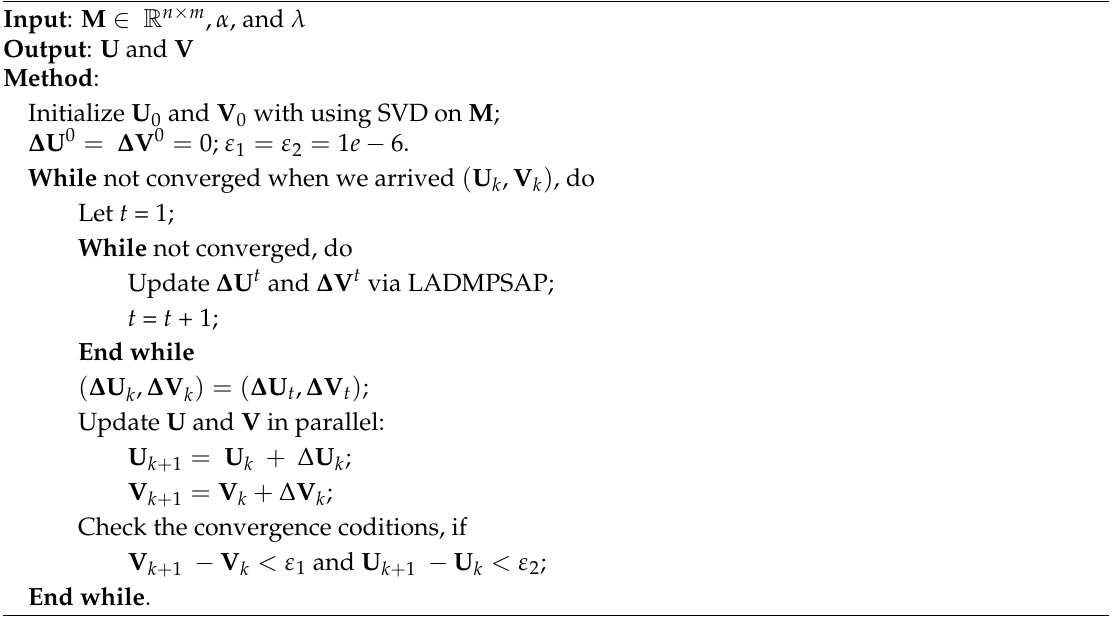
Algorithm 1 Graph regularized Robust Matrix Factorization (GRMF) by Majorization